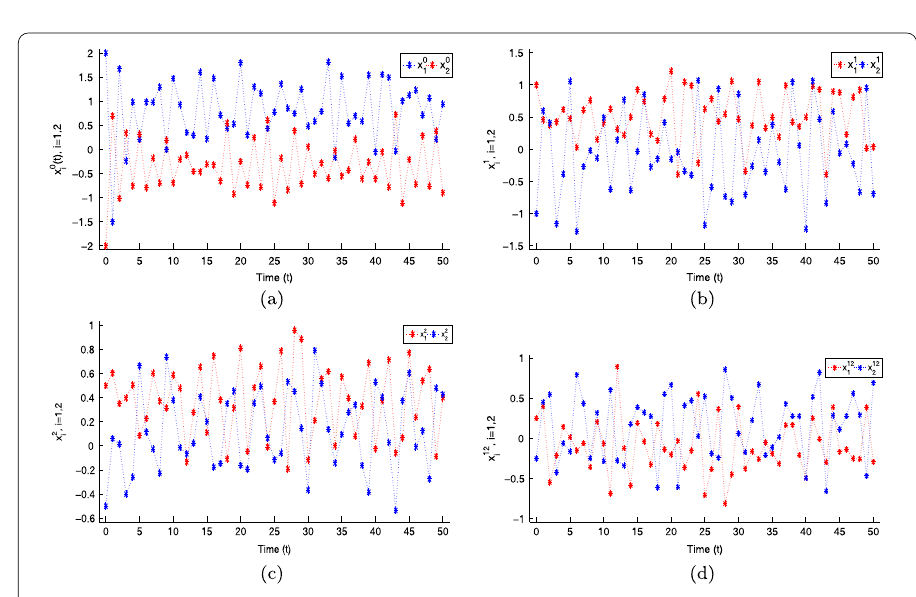
Figure 2 ( a ) Curves of x 0 ( t ) of the discrete case T = Z ; ( b ) Curves of x 1 i of x 2 i ( t ) of the discrete case T = Z ; ( d ) Curves of x 12 i ( t ) of the discrete case T =